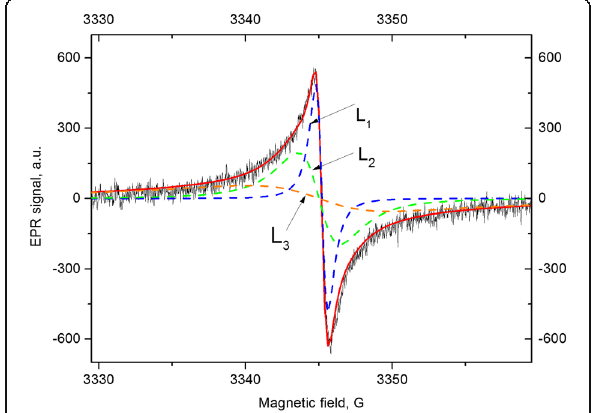
Fig. 3 The separation of the EPR spectrum into components. The sample FB after pumping out during 0.5 h at T = 300 ° C. L 1 , L 2 , and L — components of the spectrum with Δ H = 0.9, 3.0, and 24 G 3 respectively. The solid red line is the envelope of spectrum. L